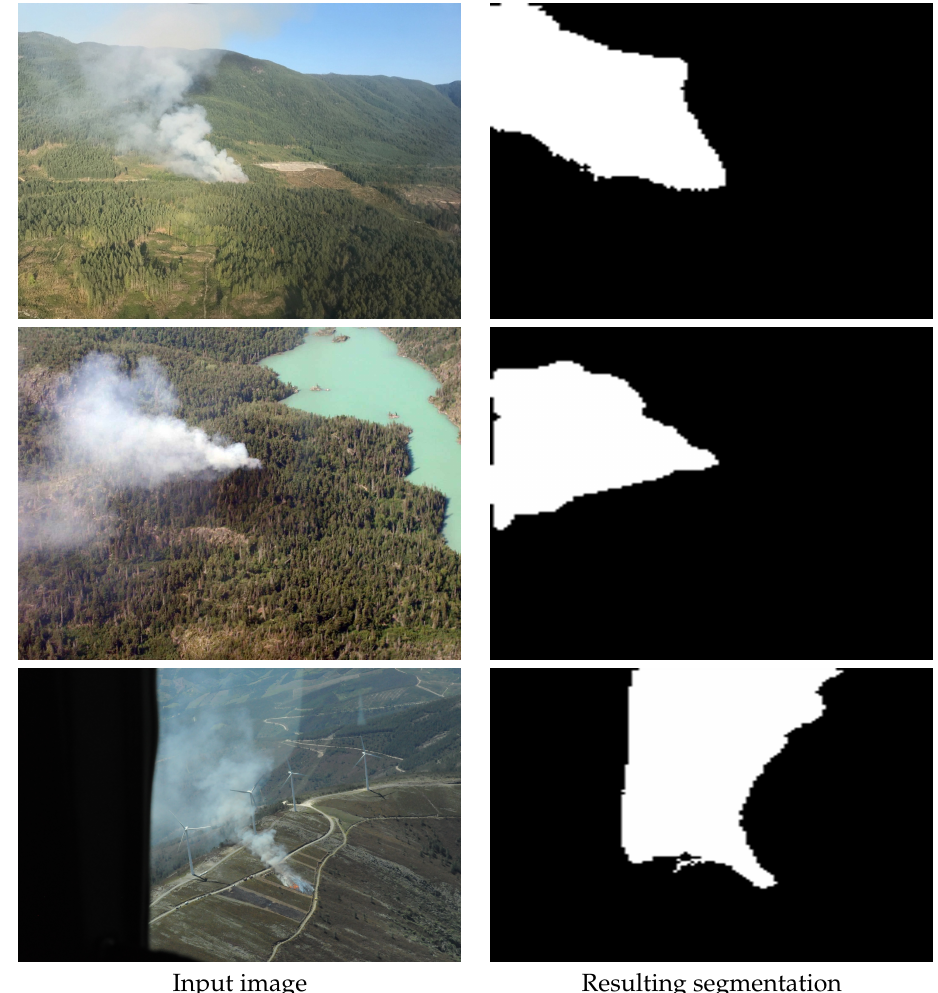
Figure 6. Example of segmentation of smoke by the proposed